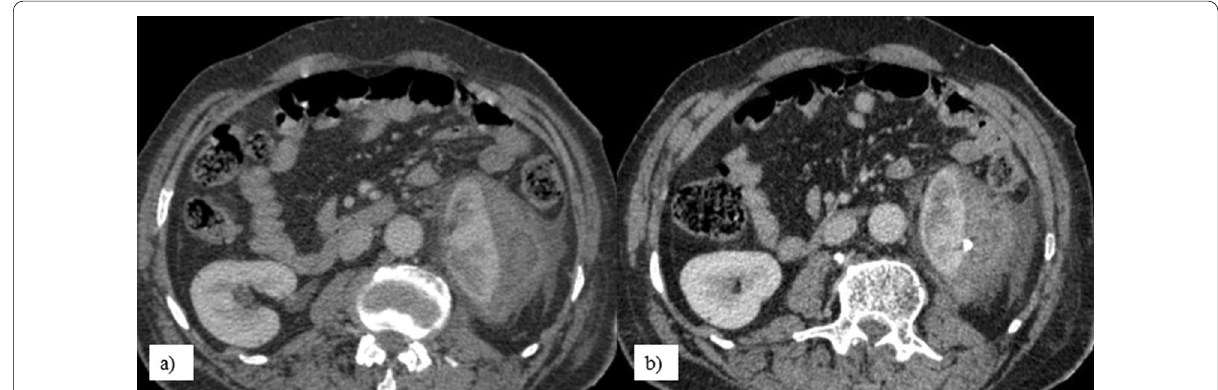
Fig. 4 Post-percutaneous drainage CECT abdomen: a and b axial images show significant reduction in the volume of perirenal pseudocyst with the tip of pigtail near lower pole of kidney